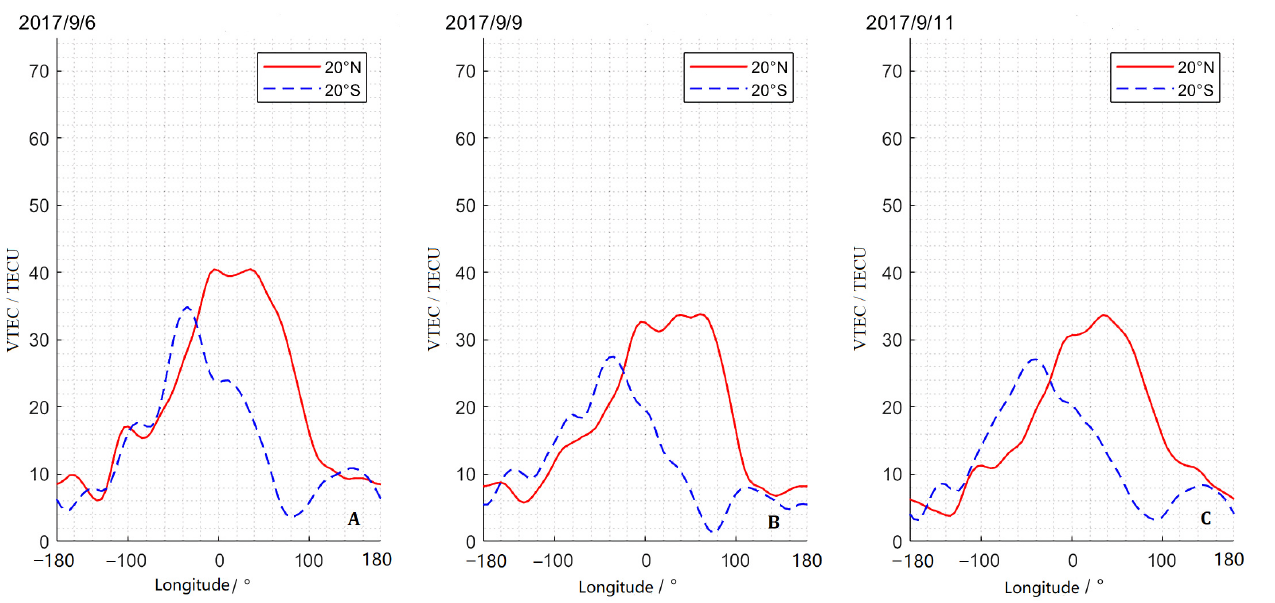
Figure 8. Fluctuation characteristics of VTEC on 10° N/S latitudes at UTC 14:00. Panels ( A – C ) rep- resent the experimental results of the three stages before, during, and after the geomagnetic storm, respectively. The blue dotted line and the red solid line represent the southern and northern hem- isphere VTEC, respectively, unit: TECU.